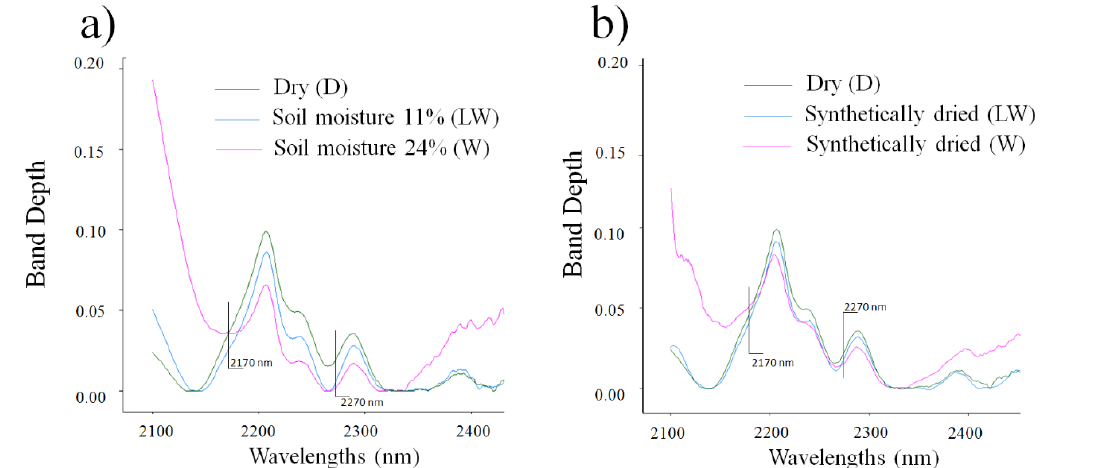
Figure 6. ( a ) Band depth spectra of a soil sample from the MAC dataset at different moisture levels; ( b ) band depth of the same sample as (a) in which wet soil data were "synthetically dried" using the procedure described in Section 2.3.2. The vertical bars represent the wavelengths used for the clay dry index (SM class